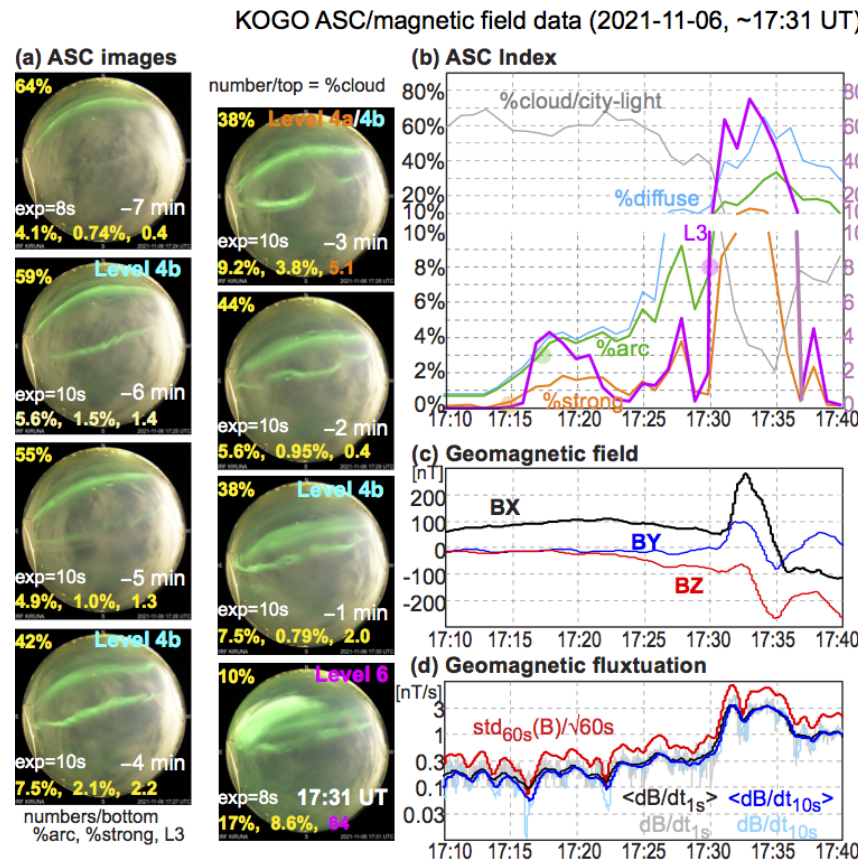
Figure 7. ASC and magnetometer data around 17:31UT on 6 November 2021: (a) aurora images (the same coordinates as in Fig. 2); (b) ASC auroral index values; (c) DC geomagnetic deviation from the baseline values ( X = north, Y = east, Z = downward); and (d) AC geomagnetic variation | d B/ d t | measured by three different methods. In each image in (a) , the ASC auroral index values of %arc, %strong, and L3 are given at the bottom, above which the automatic exposure time and UT are given. The cloud coverage (%cloud) and the activity level (Level 6, Level 4a, and Level 4b) are given at the top. The timing of Level 6 detection is the same as the onset of the local-arc breaking. In the auroral index panel (b) , the scaling is changed for below 10 and above 10 (therefore the graph has a gap in between). The three methods of | d B/ d t | in (d) are (1) using 1s values (black), (2) using 10s running average values (blue), and (3) the standard deviation of magnetic field over 60s, using 1s values and normalized to nTs − 1 unit (red). These variations are first calculated for each vector component and then for the absolute